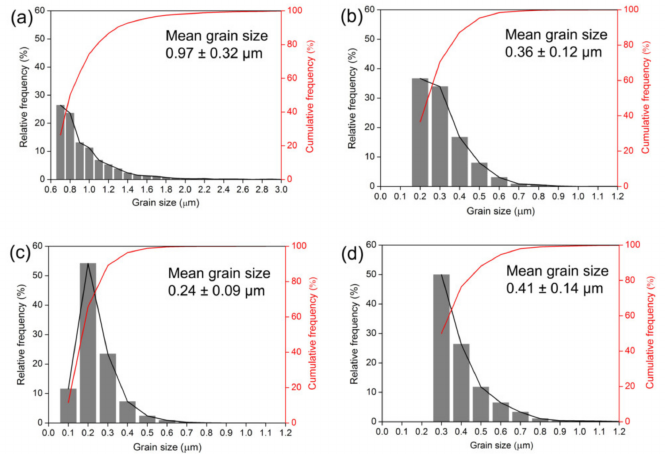
Figure 9. Average size and size distribution of WC grains in WC-10 wt. % Co sintered cemented carbides. ( a ) WC–10Co; ( b ) WC–10Co–0.8Cr 3 C 2 ; ( c ) WC–10Co–0.8VC; ( d )